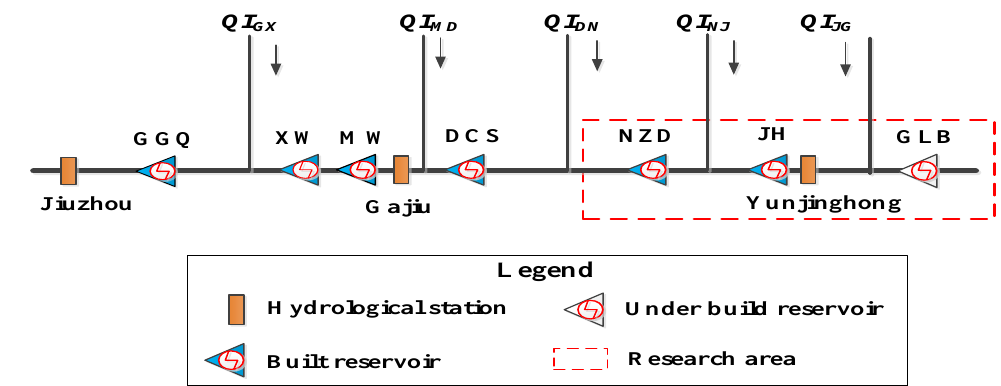
Figure 2. Network of the mainstream hydropower plants in the Lancang River.